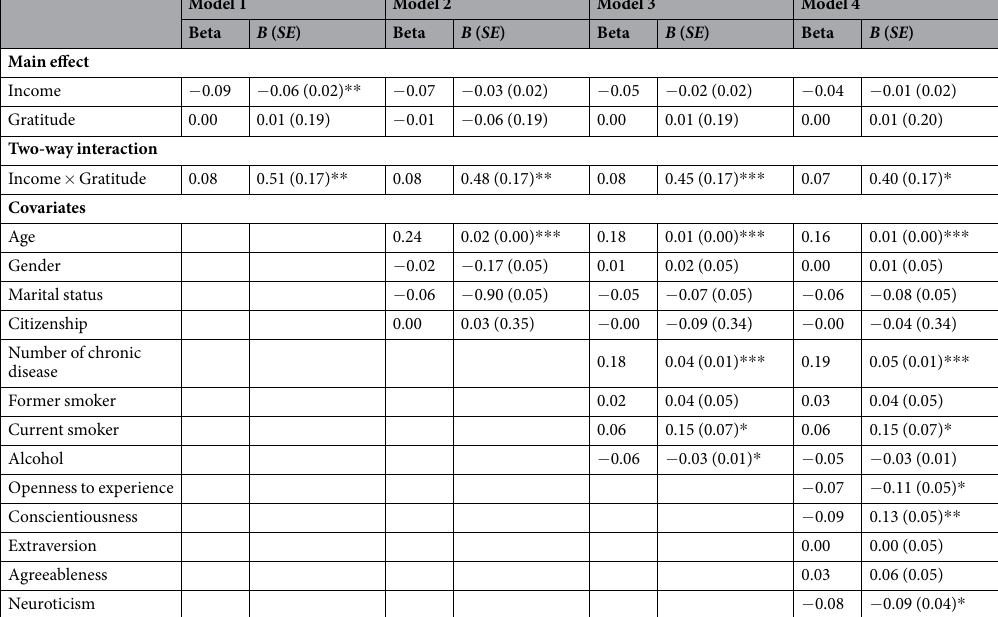
Table 2. Model Summaries of Interleukin-6 with Income and Dispositional Gratitude as Predictors. Note : Gender was dummy coded with female as reference. Marital status was dummy coded with unmarried